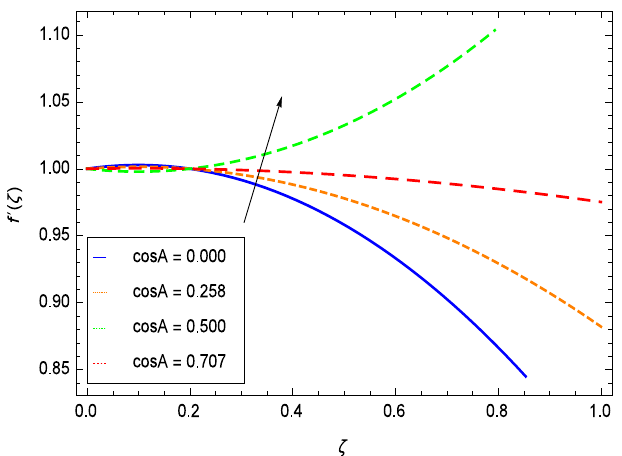
Figure 11. Flow layer at h = − 3.00, β = 0.10, φ = 0.40, M = 2.00, n = 1.50, S = 0.50, We = 0.50 with the enhancement in cos A